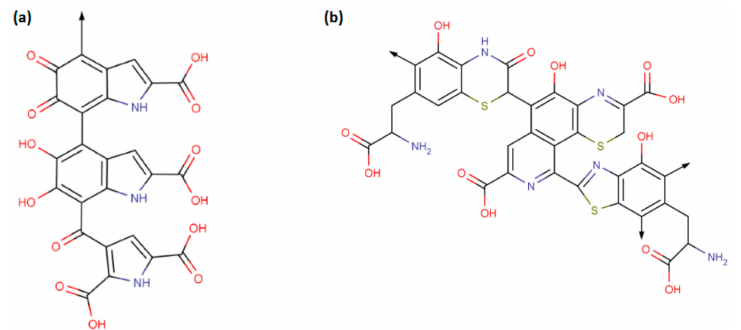
Figure 2. The chemical structures of ( a ) eumelanin and ( b ) pheomelanin as presented in Ref.